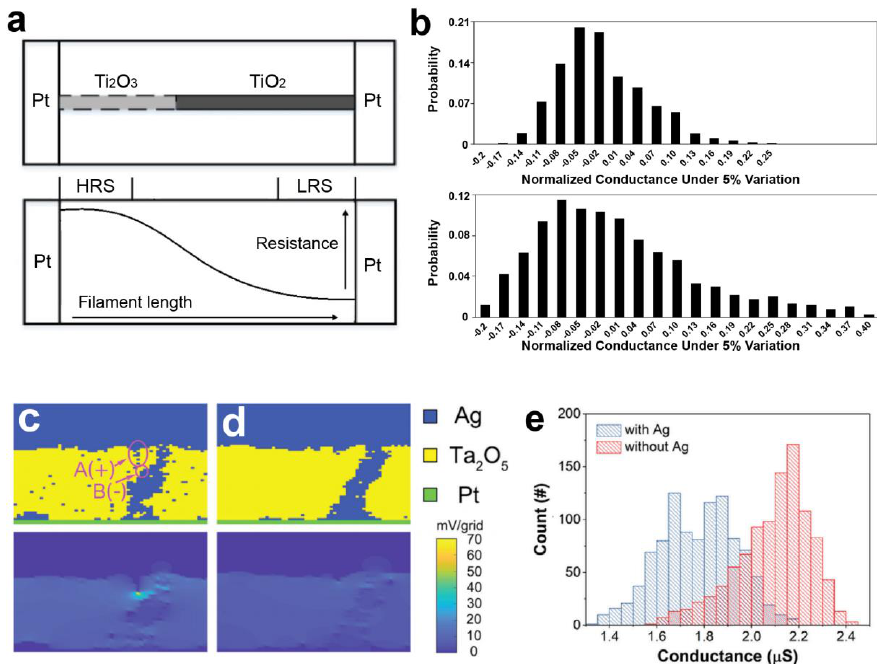
Figure 4. The memristor model with conductive filament mechanism. ( a ) A generic Pt/TiO 2 /Pt memristor device model. The top is the conductive filament growth model and the bottom is the illustration of filament length and device resistance. ( b ) The simulation device conductance conforms to the Gaussian distribution for the model. Reproduced with permission [61]. ( c , d ) Simulation of random origins observed in Ag/Ta 2 O 5 :Ag/Pt and Ag/Ta 2 O 5 /Pt devices. ( e ) Simulated conductance distribution for the LRS of the Ag/Ta 2 O 5 :Ag/Pt and the Ag/Ta 2 O 5 /Pt devices. Reproduced with permission. [66] Copyright 2020, Wiley−VCH.